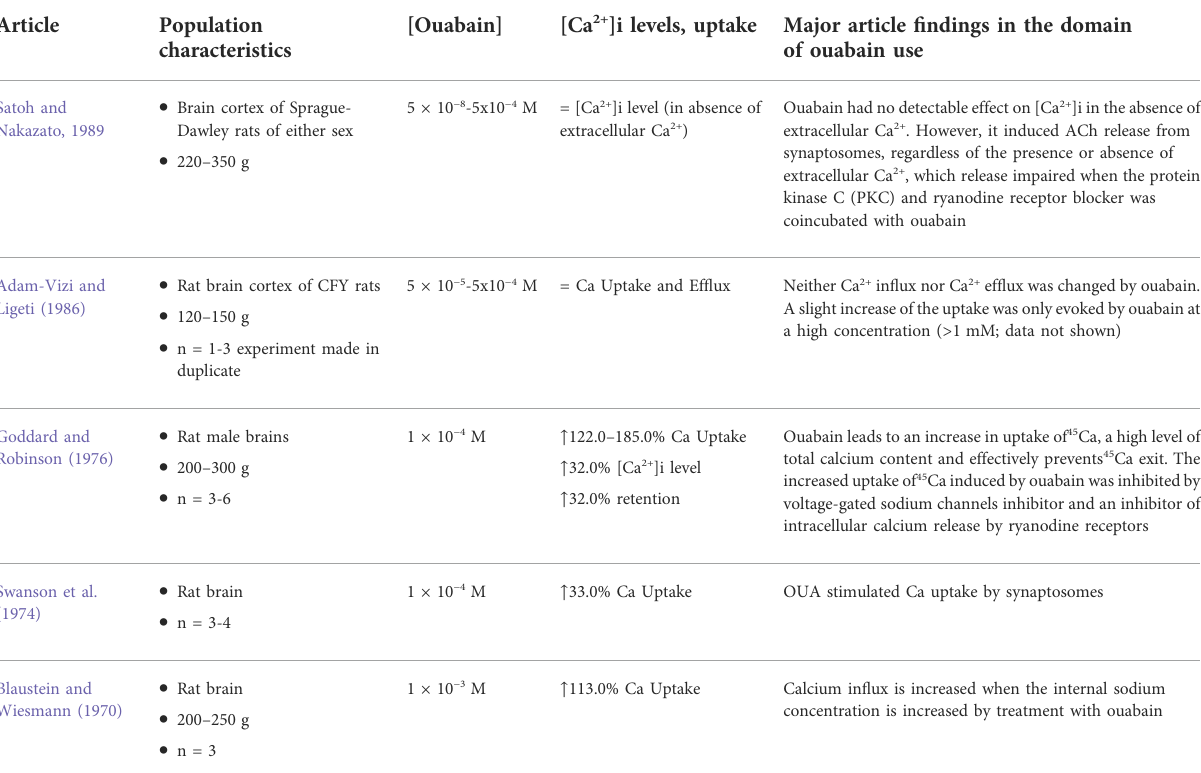
FIGURE 2 Flow diagram of study selection. The search process using the PRISMA fl ow diagram.